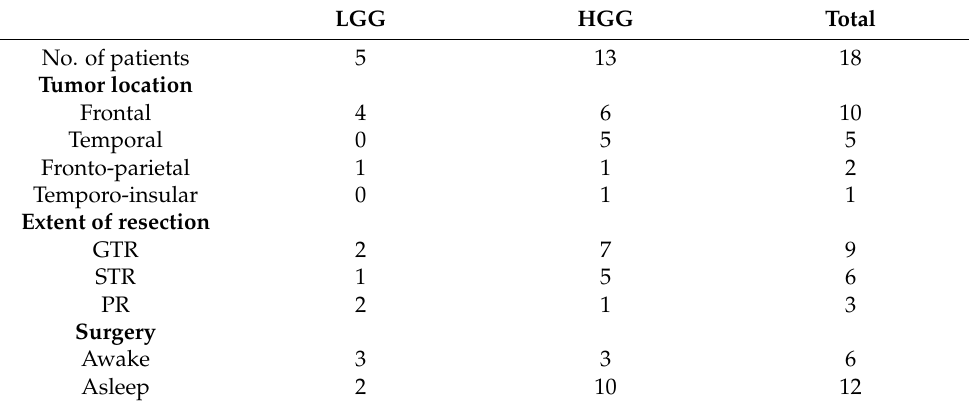
Table 1. Summary of tumor location, extent of resection and surgery; GTR, gross total resection,